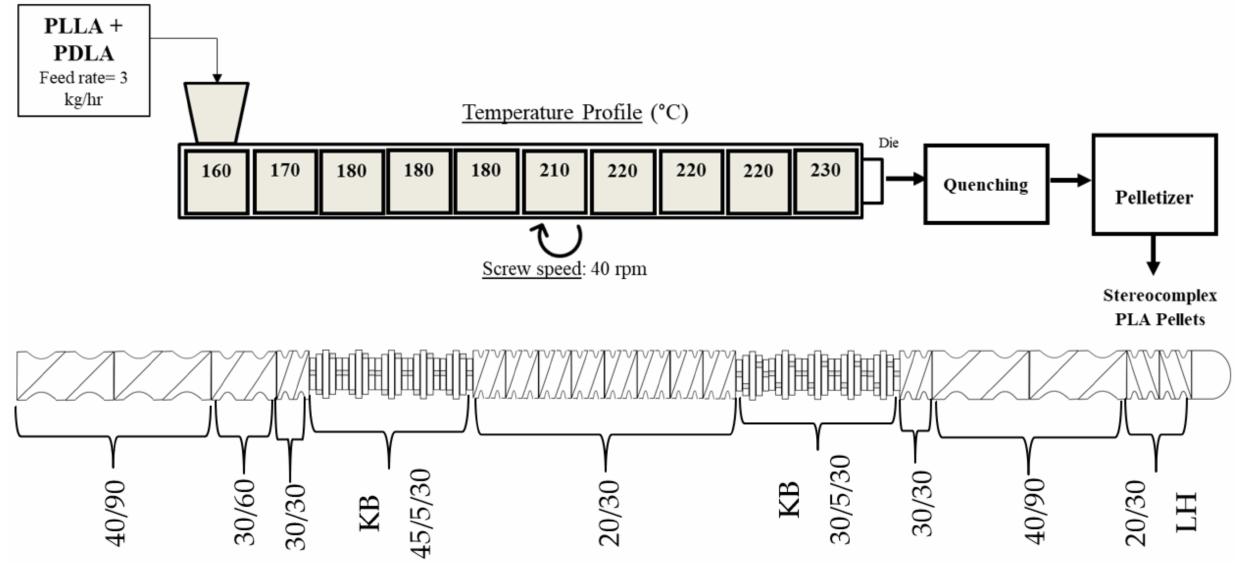
Figure 5. Processing conditions for the new trial run of stereocomplex PLA in a co-rotating twin-screw extruder type ZSE 27 HP–PH from